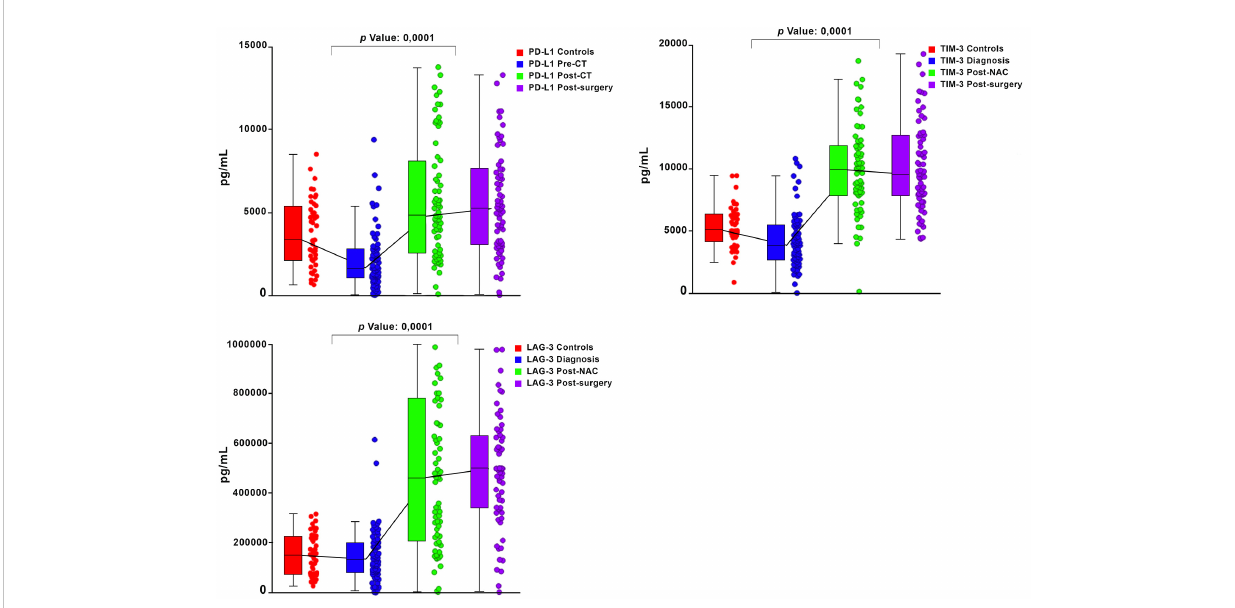
FIGURE 2 Box and whisker plots depicting the progressive changes in the median plasma concentrations (with 95% con fi dence limits) of three co-inhibitory immune checkpoints (PD-L1, TIM-3 and LAG-3) throughout the course of neoadjuvant chemotherapy (NAC) (pre-treatment/diagnosis, post-NAC and post-surgery) in relation to the corresponding median values of the control subjects. The p values represent the comparison between the pre- treatment/diagnosis and post-NAC